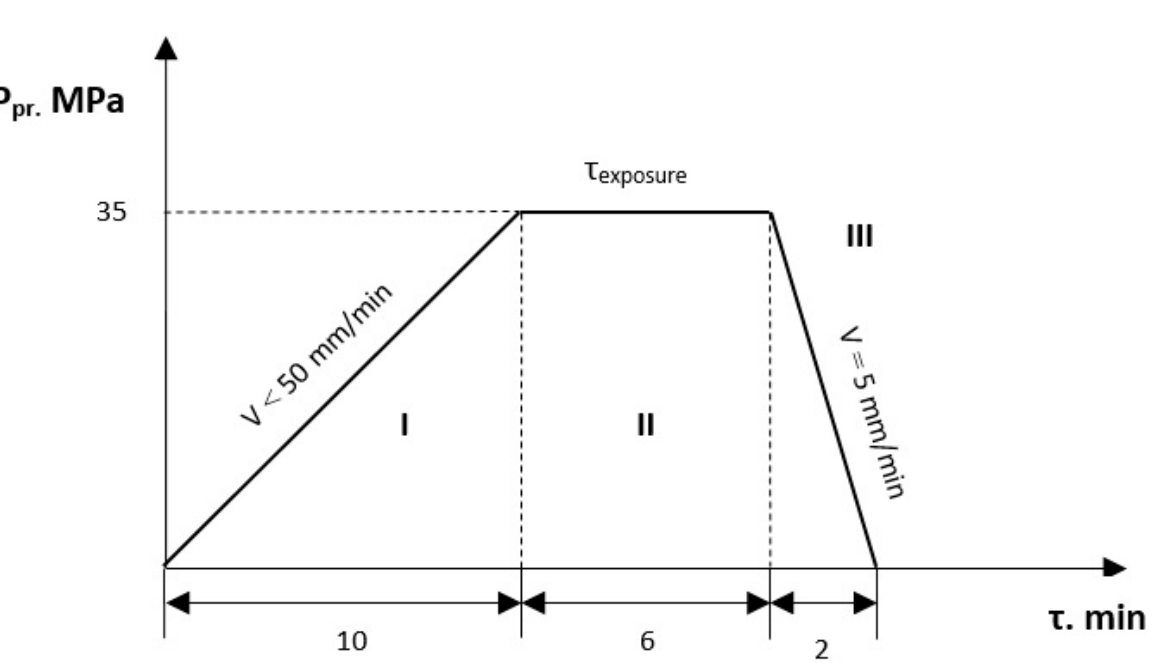
Figure 1. Graph of the real process of pressing PTFE-composition by the MS-500 press: I – pressure rise, II – endurance at maximum pressure, III – pressure relief.